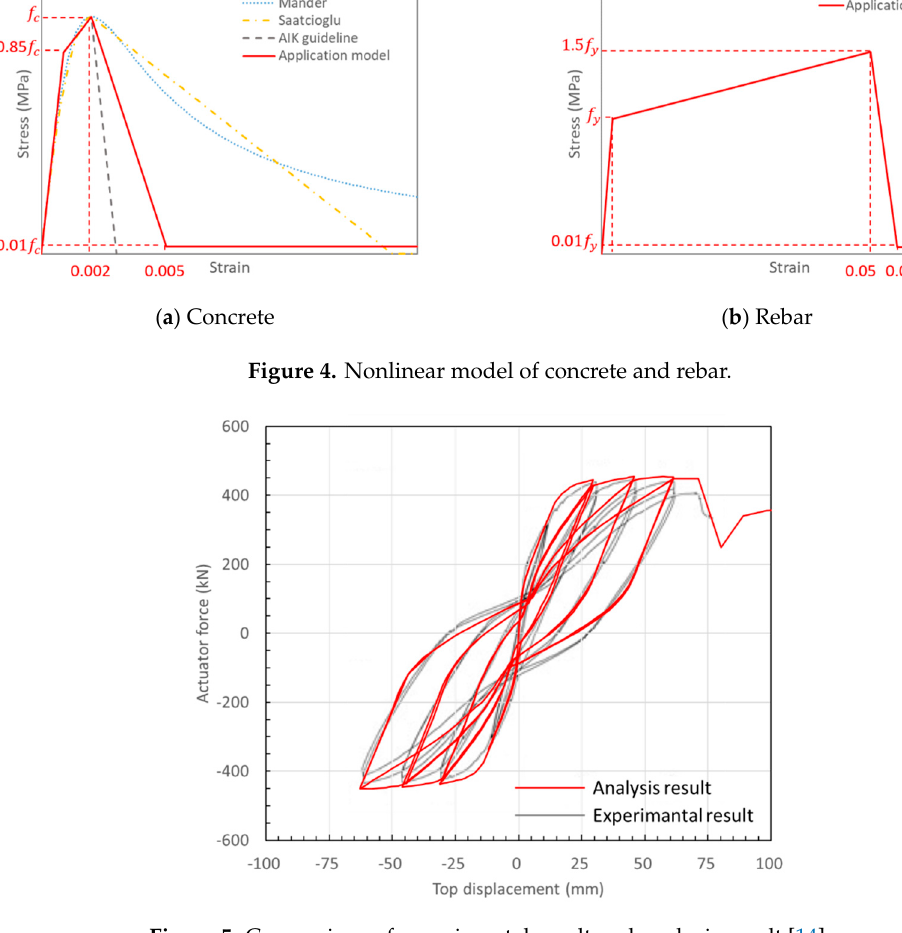
Figure 5. Comparison of experimental result and analysis result [14].